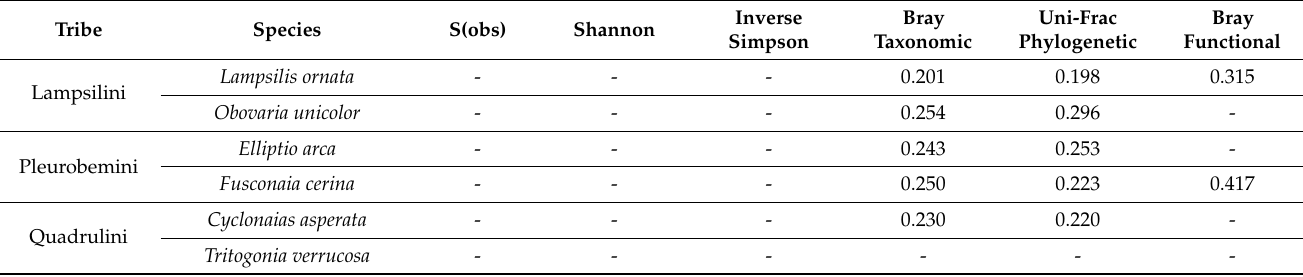
Figure 3. Principle coordinates analyses representing Bray-Curtis ( a ) and W-Unifrac dissimilarities ( b ) between six species of Unionidae mussels sampled at the same site on the Sipsey River, AL, USA, across two years. Mussel species were Lampsilis ornata , Obovaria unicolor , Elliptio arca , Fusconaia cerina , Cyclonaias asperata , and Tritogonia verrucosa . The overall effects of species and year on microbiome structure were assessed using separated PERMANOVAs, with results ( p < 0.001 for all) indicated on each plot. Table 1. R 2 values for significant pairwise temporal comparisons of alpha indices and beta dissimilarity indices of six species of Unionidae mussels sampled at the same site on the Sipsey River, AL, USA, across two years. Only significant comparisons ( p < 0.05) are shown. Each species is represented by 3–5 individuals in 2016 and 8–10 individuals in